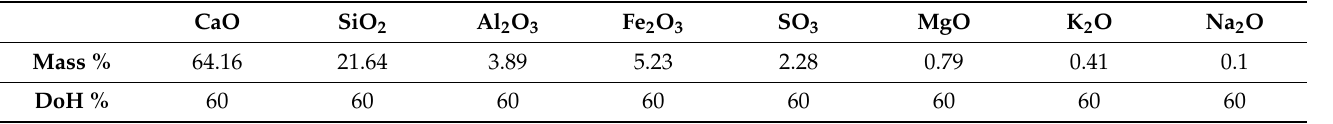
Table 1. Oxide composition of the class G oil-well cement, after [33] and assumed degree of hydration,